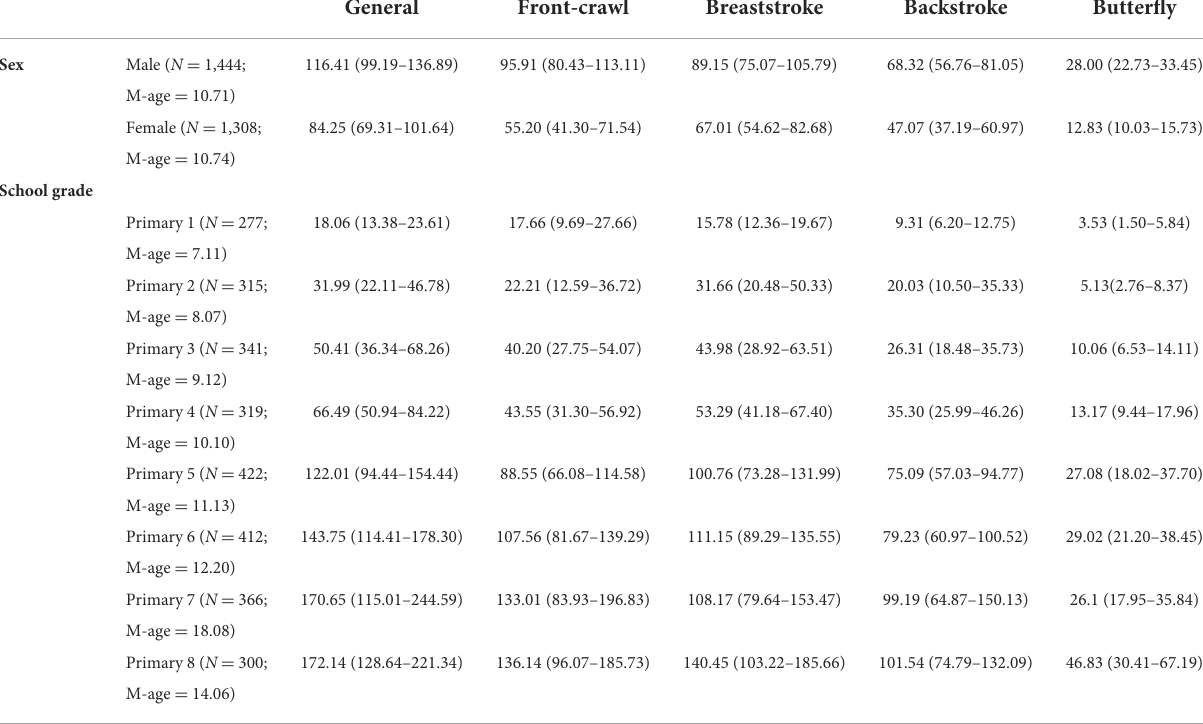
TABLE 2 Maximum swimming distance by sex and school